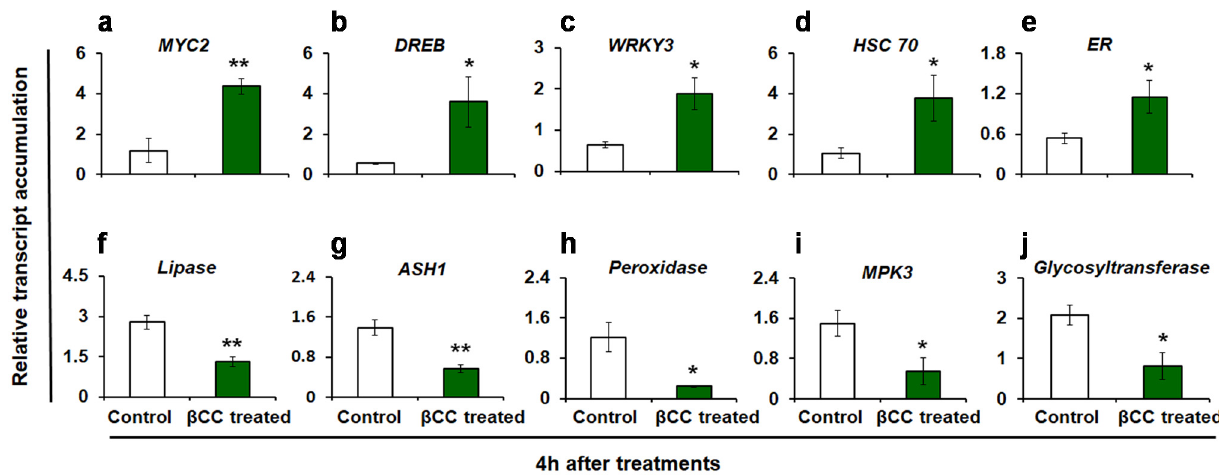
Figure 2. Validation of RNA sequencing results by quantitative real-time (q-RT) PCR. Relative transcript accumulations of ten candidate genes were evaluated by q-RT PCR. Similar to the RNA sequencing data, in β CC-treated plants, the relative transcript accumulations of ( a ) MYC2 , ( b ) DREB 3, ( c ) WRKY3 , ( d ) HSC70 , and ( e ) ER are significantly higher and transcript accumulations of ( f ) lipase , ( g ) ASH1 , ( h ) peroxidase , ( i ) MPK3 , and ( j ) glycosyltransferase are significantly lower as compared to control plants. Values are the mean ± SE of four replicate plants from each treatment. Significant differences are determined with Student’s t -test. Asterisks indicate significance at * p ≤ 0.05, ** p ≤ 0.005. Dehydration responsive element-binding 3 , DREB3 ; Heat shock cognate 70 , HSC 70 ; Ethylene receptor , ER ; Acylsugar acylhydrolase 1, ASH1 ; Mitogen-activated protein kinase 3 , MPK3 .